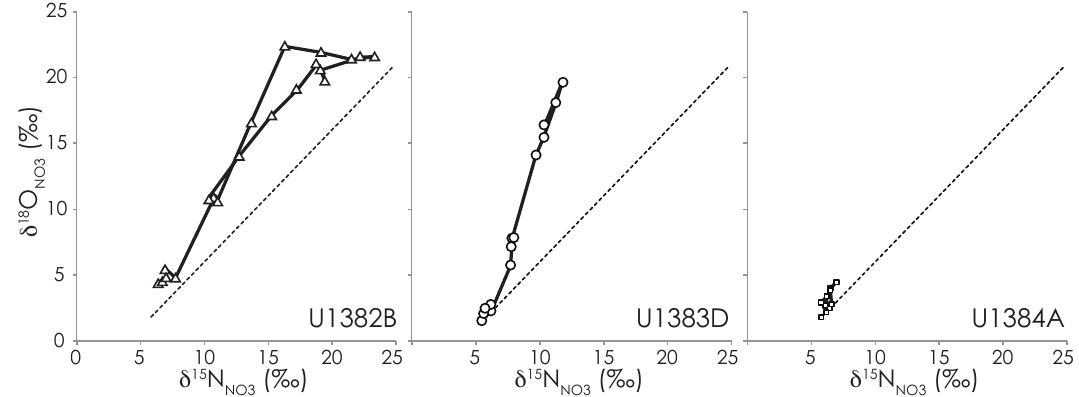
Figure 3. Dual isotope plot illustrating the relationship between δ 15 N NO at a value for bottom seawater ( δ 15 N of + 5.5‰ and δ 18 O of + 1.8‰ ), depicts a 1:1 slope representative of the expected change in δ 15 N and δ 18 O by the process of denitrification alone. Trends falling well above this 1:1 line, together with the concentration profiles reflect the combined role of nitrification in these